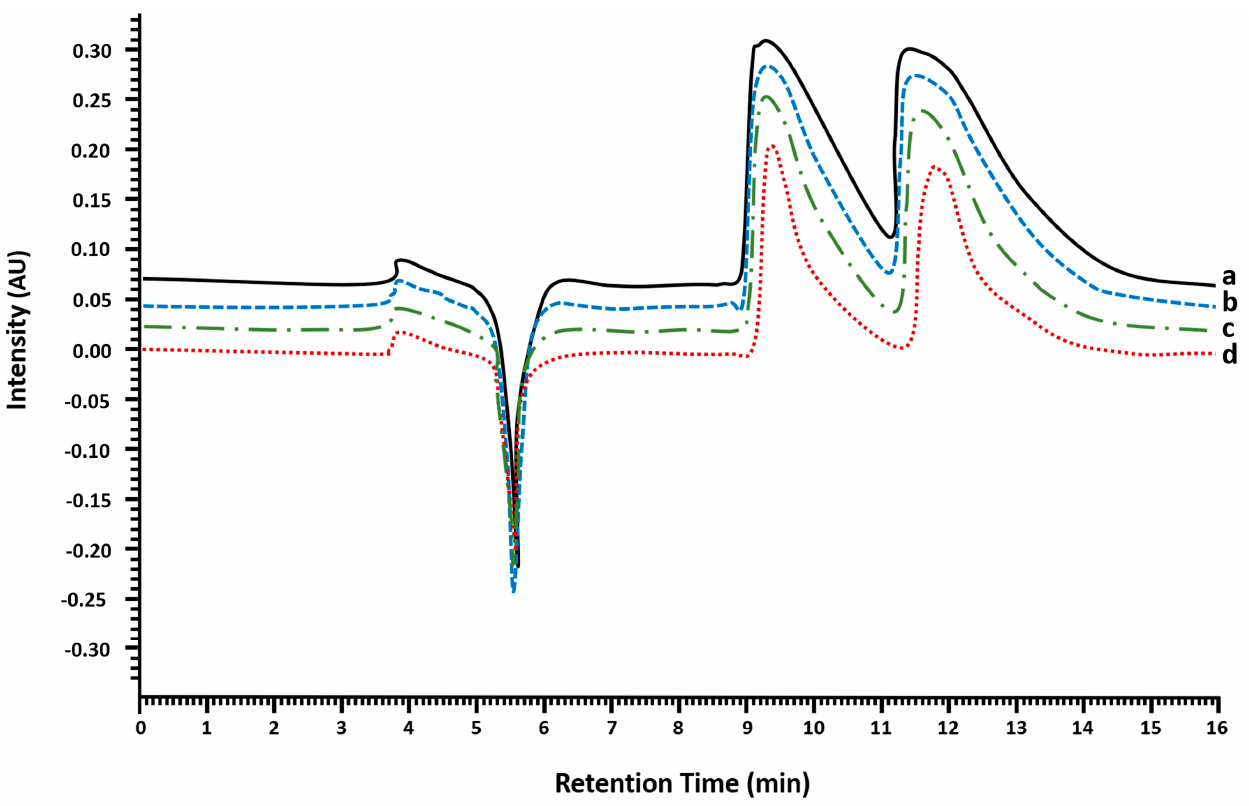
Figure 1. Chromatogram showing the injection volume optimization for the enantioseparation of ( R , S )-MDMA in a semipreparative amylose 3,5-dimethilphenylcarbamate column by LC-DAD at normal elution mode. Mobile phase: n -Hex (0.1% DEA) and EtOH (0.1% DEA), 80:20 v / v ; flow rate: 1.5 mL min − 1 ; detector: 210 nm. Standard solution at 30 mg mL − 1 (EtOH). Injection volume: Line (a) 20 µL; line (b) 15 µL; line (c) 10 µL; and line (d) 5 µL.